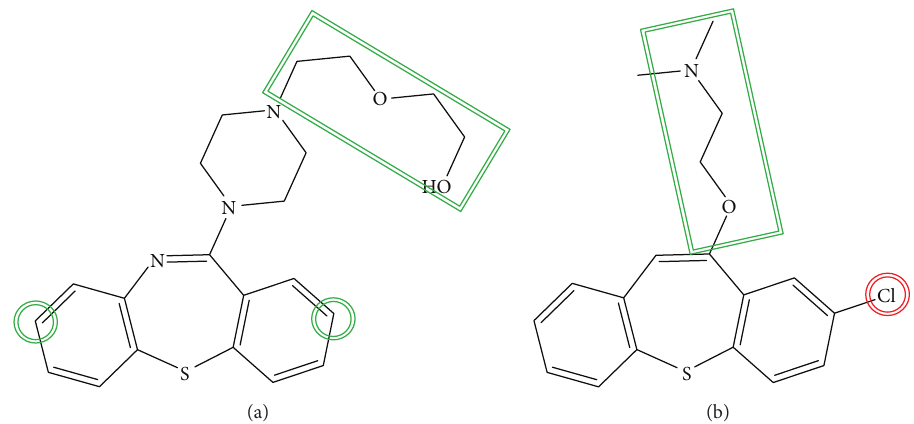
Figure 2: Limitations of current antipsychotic therapies (a) quetiapine; (b)